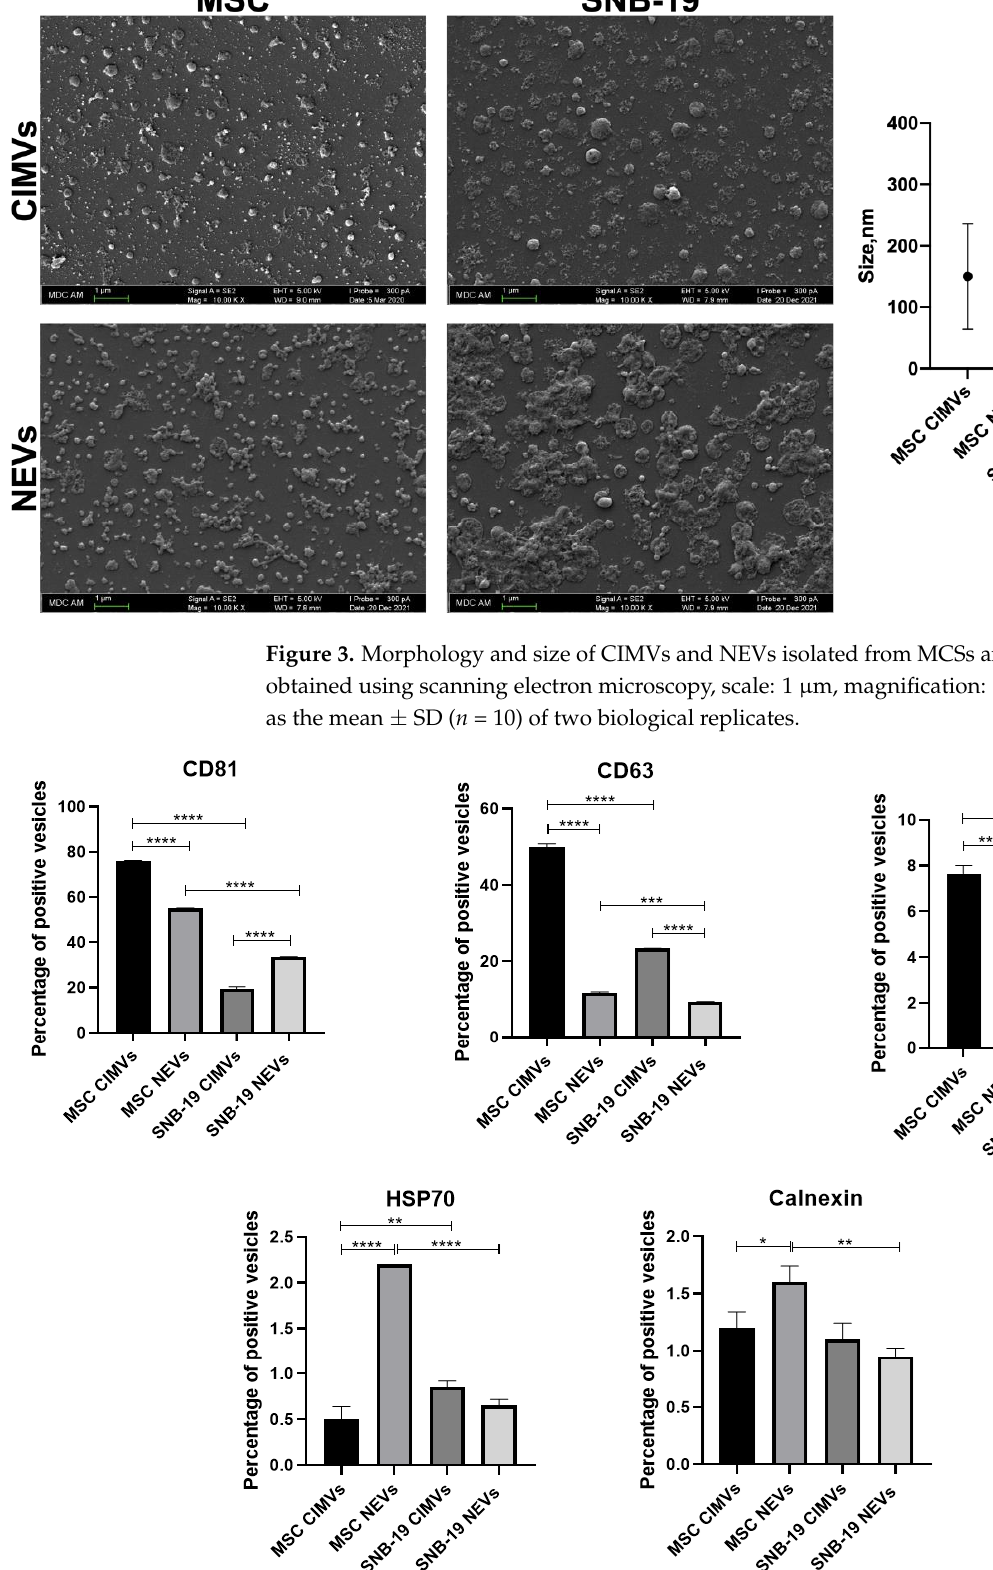
Figure 4. Analysis of the expression of typical EV markers on the CIMVs and NEVs. Data are shown as the mean percentage ± SD (n = 6) of two biological replicates. * p < 0.05, ** p < 0.01, *** p < 0.001, **** p < 0.0001.